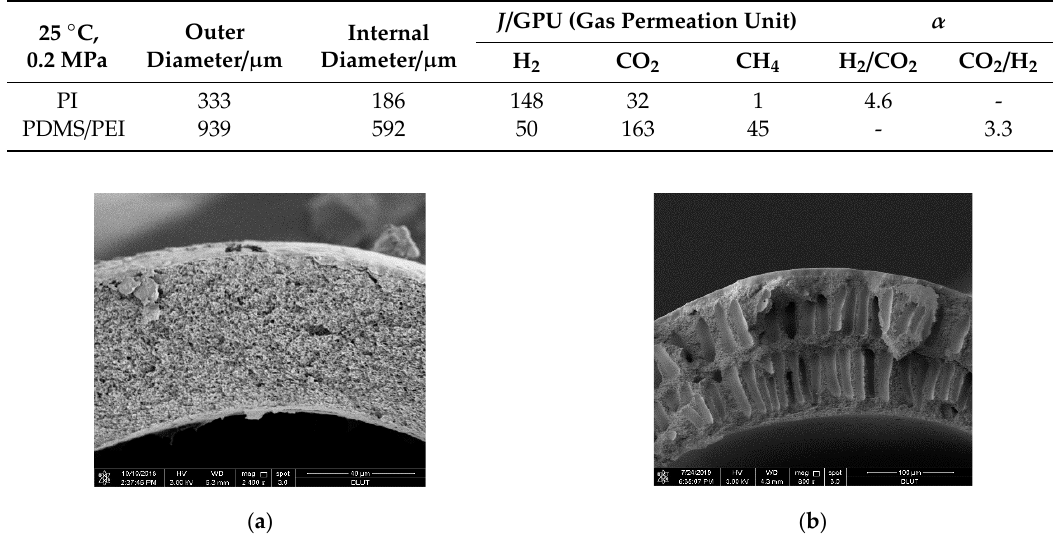
Figure 3. Scanning electron microscope (SEM) images of the cross-section structure of the two hollow fiber membranes. ( a ) Polyimide (PI) hollow fiber membrane; ( b ) polydimethylsiloxane/polyetherimide (PDMS/PEI) hollow fiber composite membrane.